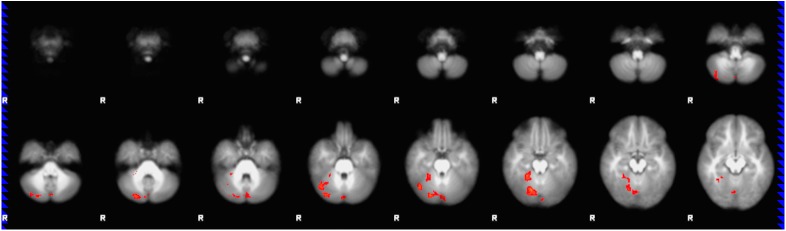
Regression map for the story listening task (stories>tones activation) with child engagement score applied as explanatory variable.Regression map for the story listening task (stories>tones; n = 22), with child engagement score as the explanatory variable. Total cluster size 1164 voxels (p<0.05, FDR corrected), with center of gravity at (x = 21, y = -67, z = -25; R posterior cerebellum) in MNI coordinate space and z-score local maxima 3.22–3.93. Shown as 5 mm slices from z = -64 to z = -12 in MNI coordinate space. Color scale from t = 1.25 (cooler) to 4 (hotter). Radiological orientation, left = right, right = left.